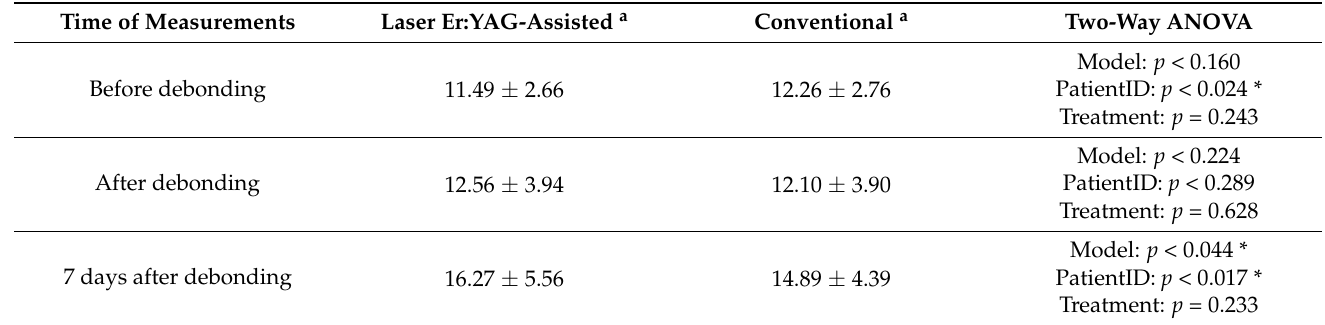
Table 3. The results for the statistical analysis of the laser Doppler flowmetry measurements. Time of Measurements Laser Er:YAG-Assisted a Conventional a Two-Way